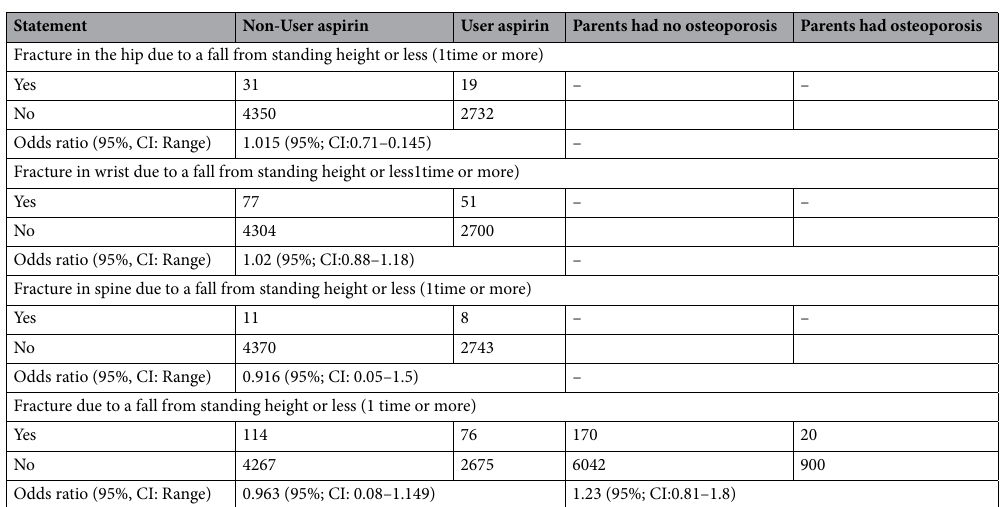
Table 3. Estimating odds ratio of preventive low dose aspirin use and having the parent’s osteoporosis with occurrence of fractures due to a fall from standing height or less.